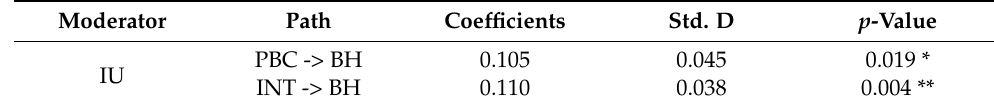
Table 6. Moderation Analysis.